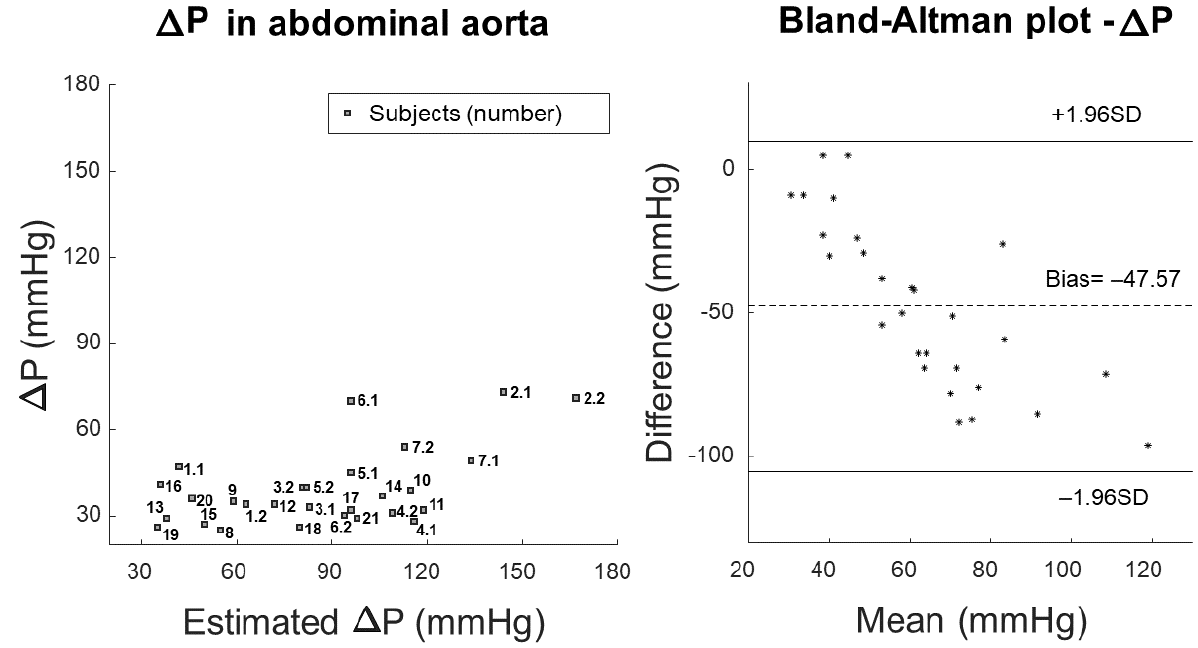
Figure 5. Comparison of pressure variation either measured or estimated by inverting Bramwell-Hill equation and using the measurements of PWV and pulsatility (correlation coefficient 54.5%). Scatter plot ( left ) and Bland-Altman representation ( right ).